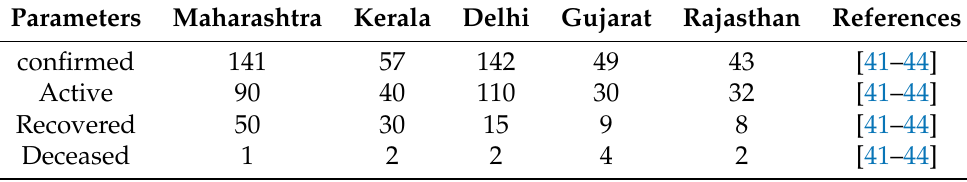
Table 7. Number of Omicron cases across Indian states and union territories as of 30 December 2021. Parameters